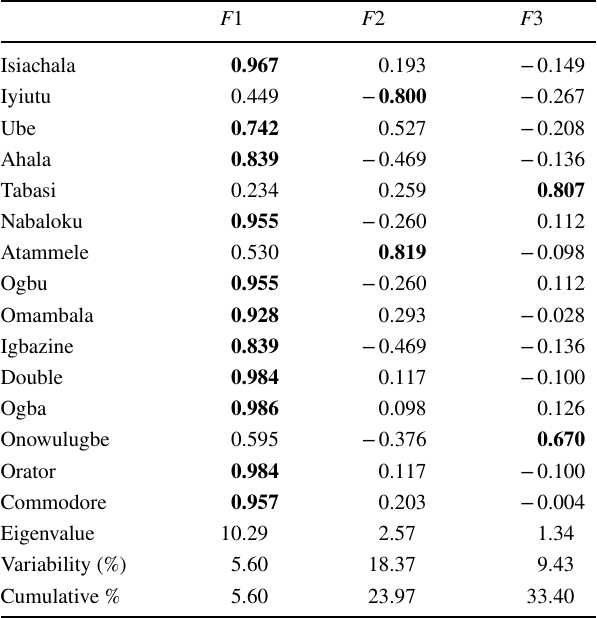
Table 6 Factor matrix of sample locations